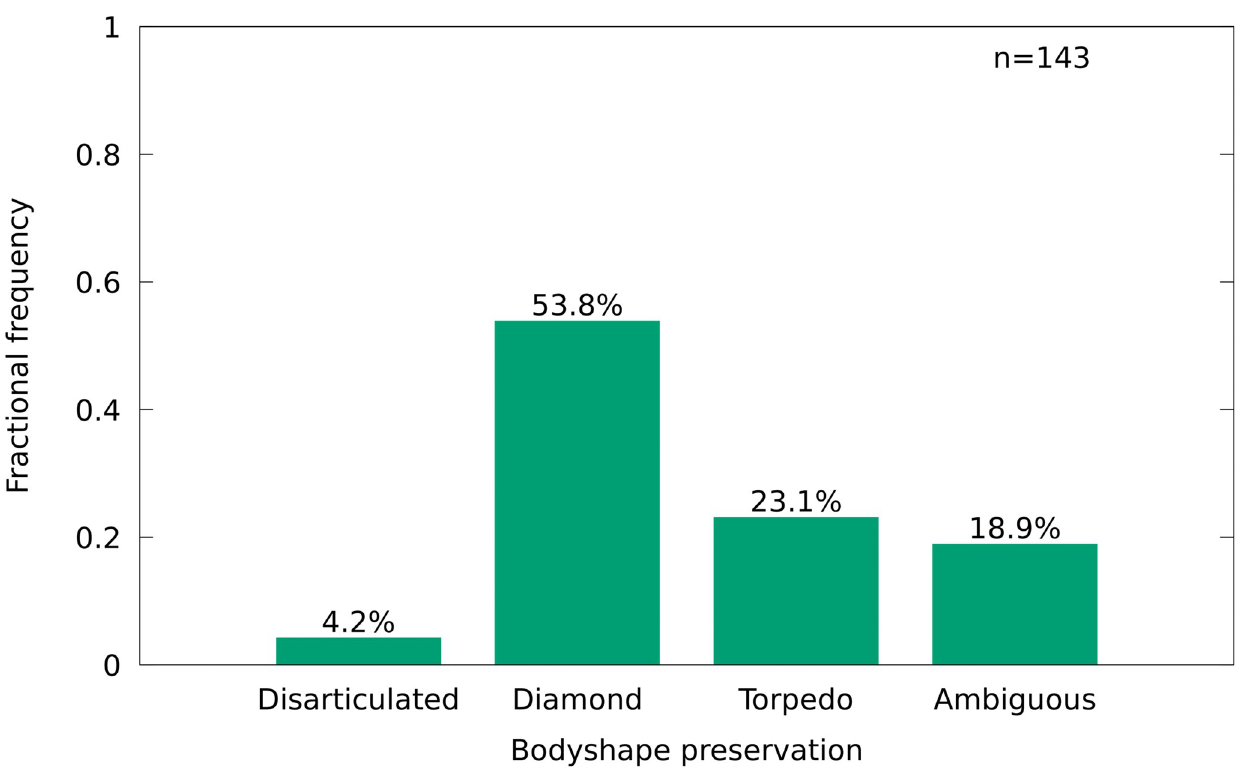
Fig 5. Diamond-shaped, torpedo-shaped and disarticulated individuals of T . formosa in percentage.